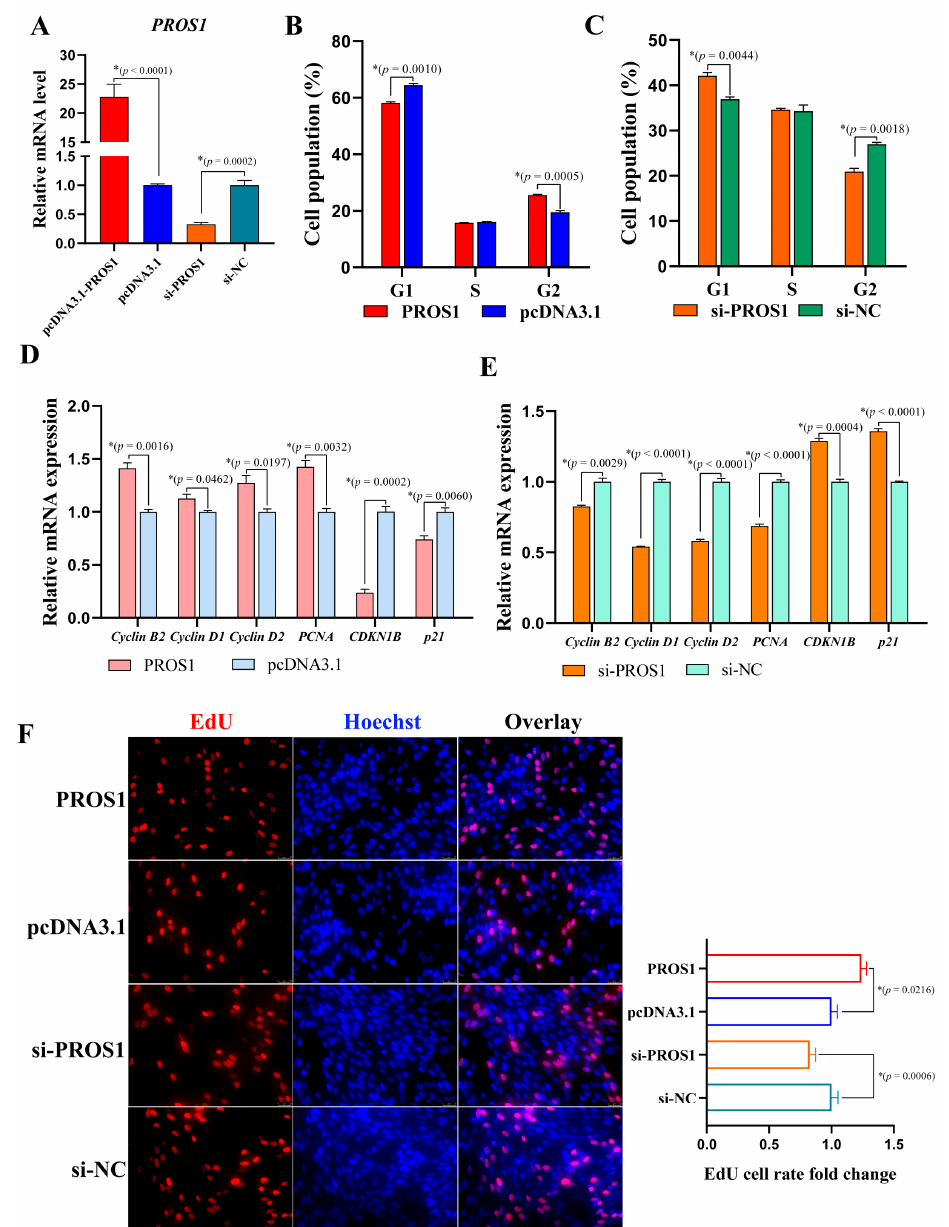
Figure 2. PROS1 facilitates chicken preadipocyte proliferation. ( A ) The overexpression efficiency or knockdown efficiency of pcDNA3.1- PROS1 or si- PROS1 . ( B , C ) The flow cytometry analysis of ICP-1 treated with PROS1 overexpression and knockdown. ( D , E ) The mRNA levels of cycle-related genes in ICP-1 treated with PROS1 overexpression and knockdown were detected by qTR-PCR. ( F ) The EdU staining and statistics of ICP-1 treated with PROS1 overexpression and knockdown. The results are all presented as means ± SEM, * p < 0.05.